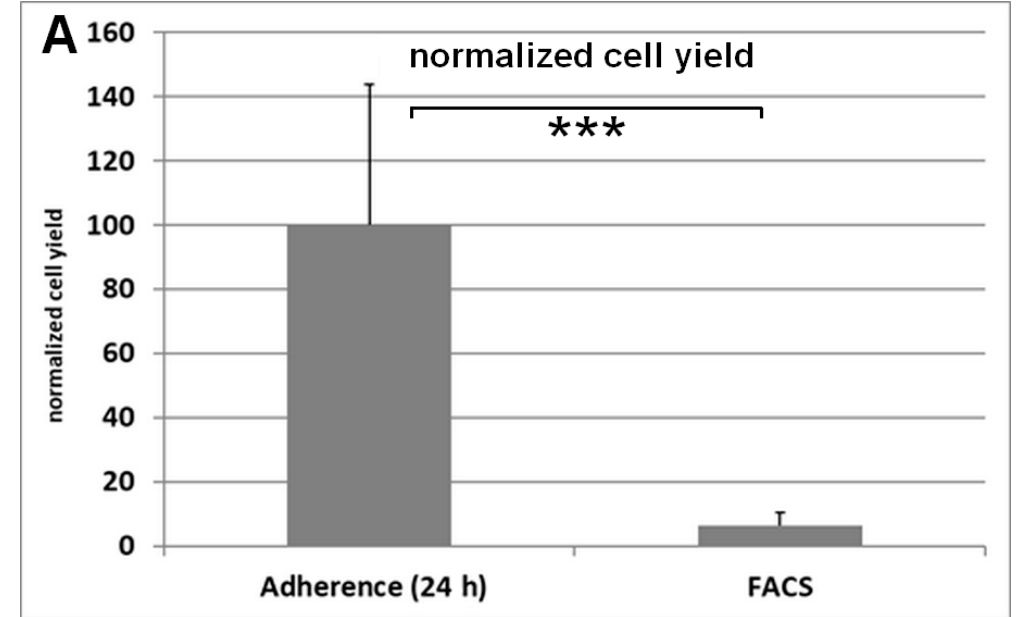
Figure 5. Calculated cell yield from the same lipoaspirate is decreased about 15-fold when detecting the CD44 + CD90 + -positive ASCs with flow cytometry instead of counting the adherent cells after 24 h. Results are shown as mean ± SD. Student’s test was used to assess statistical significance (***: p < 0.001).